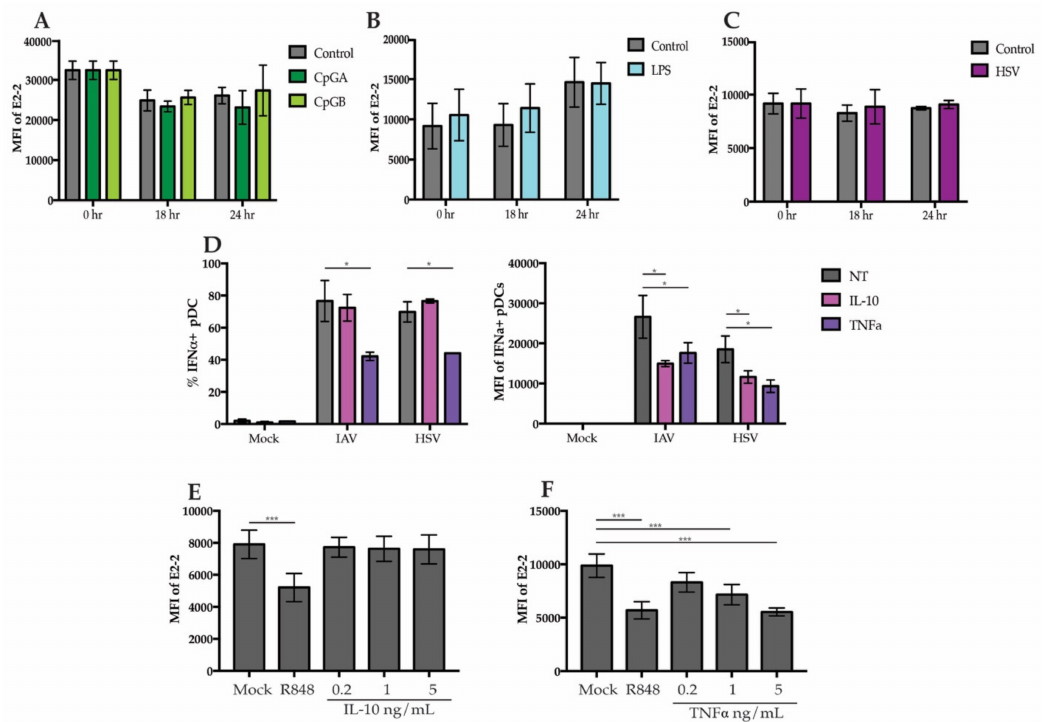
Figure 4. E2-2 expression is mediated by a pDC extrinsic signal ( A – C ) pDCs enriched to a purity > 90% were stimulated for 18 or 24 h with ( A ) 5 ug / mL CpGA or CpGB ( B ), 200 ng / mL LPS or ( C ), HSV. ( D ) PBMCs were cultured with 5 ng / mL of IL-10 or TNF α and stimulated with HSV or IAV. Intracellular IFN α production was measured at 6 h. ( E , F ) PBMCs were treated with either 10 µ M R848, 0.2, 1, or 5 ng / mL IL-10 ( E ) or TNF α for 6 h then E2-2 expression was measured by flow cytometry. n = 3 independent experiments. Data are presented as means ± SEM. p values < 0.05 were considered significant. * p < 0.05, ** p < 0.01, *** p <